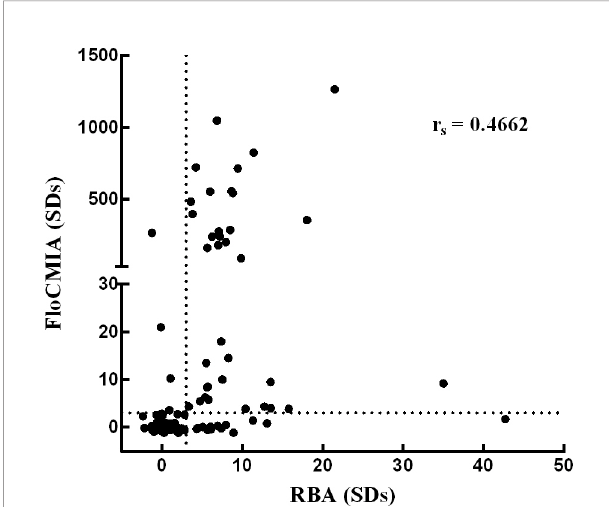
FIGURE 6 | Comparison of PAA detection by FloCMIA using recombinant TrxPI produced in bacteria and by RBA using in vitro translated 35 S-human PI. One hundred sera from normal control individuals and from 51 type 1 diabetic patients were tested. Results are expressed as SDs. Values above cut-off dotted lines were considered